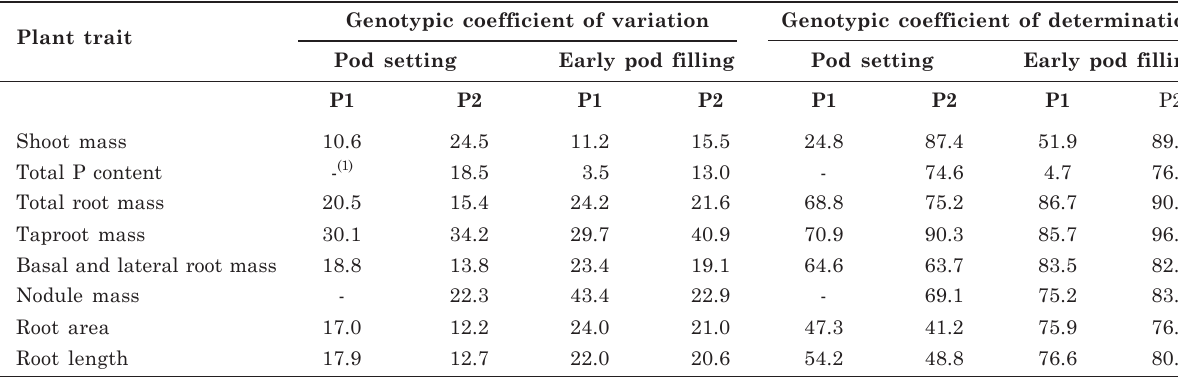
(1) - : not estimated due to negative values of genotypic